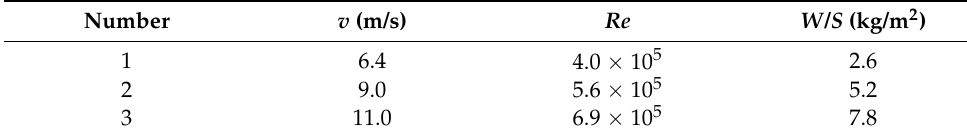
Table 3. The equivalent mechanical properties of the membranes.